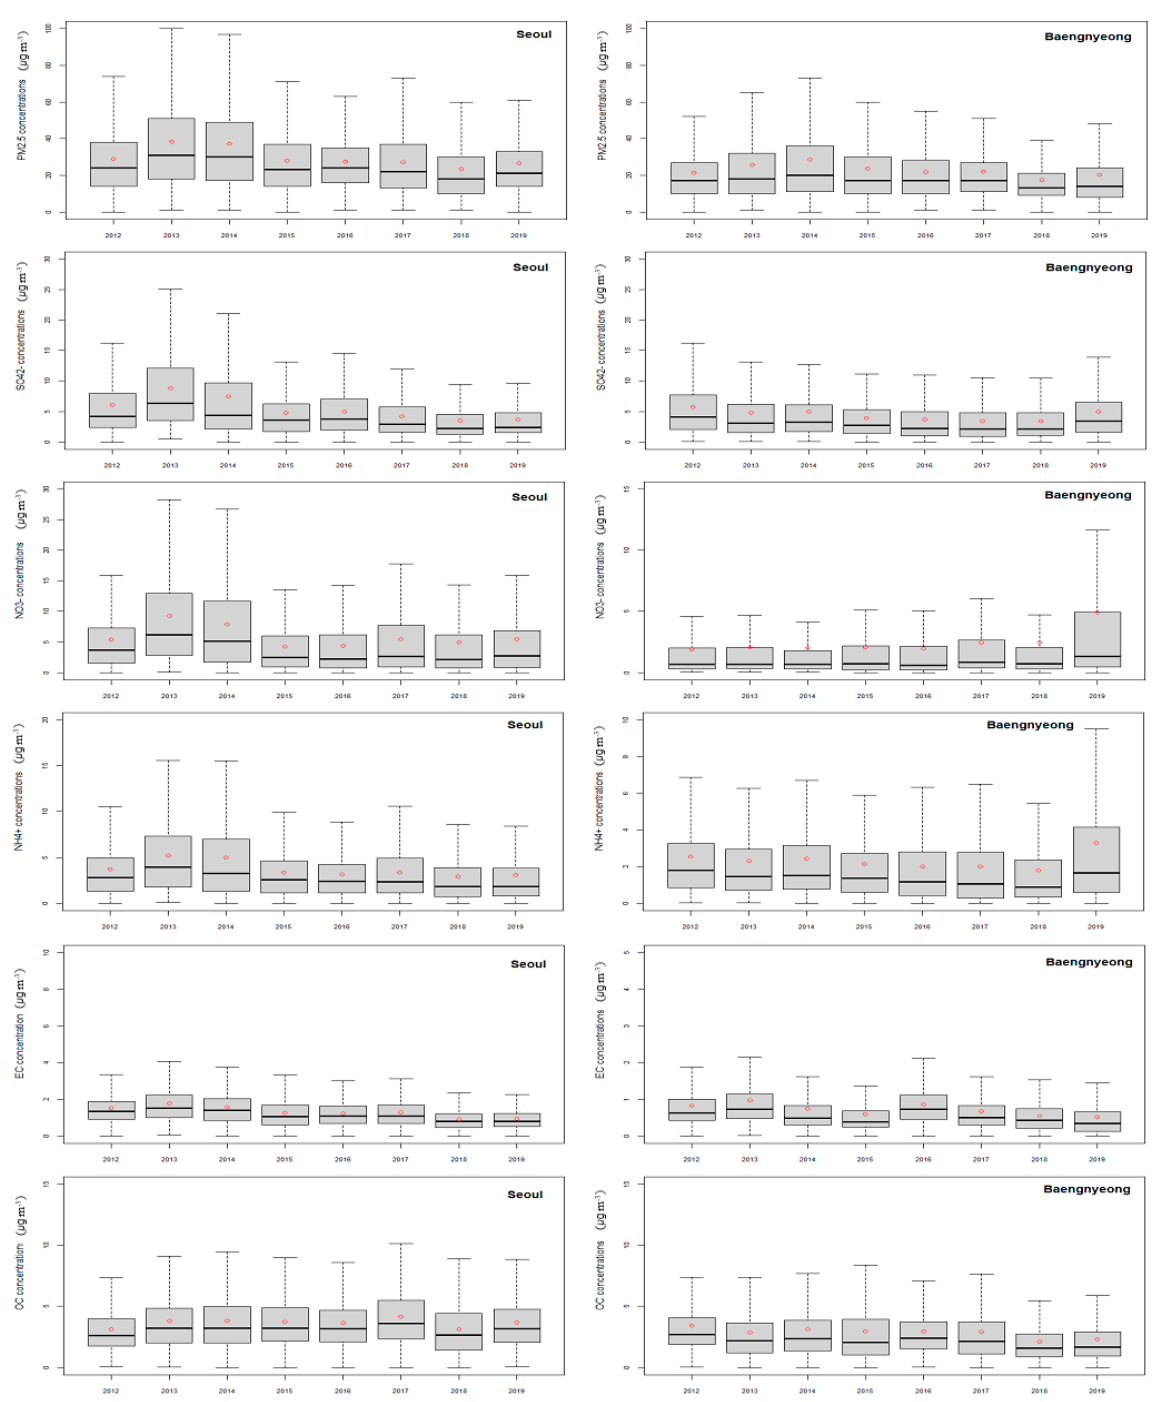
Figure 1. The annual levels of major atmospheric aerosols. The annual mean (red circle), minimum, interquartile range (Q1), median, interquartile range (Q3) and maximum values are shown.